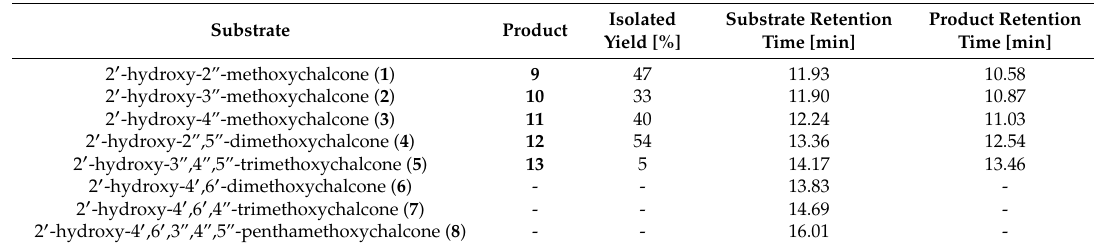
Table 4. Compounds mass after extraction (preparative scale) [mg]—in relation to 100 mg of substrate used and retention times based on GC. Substrate